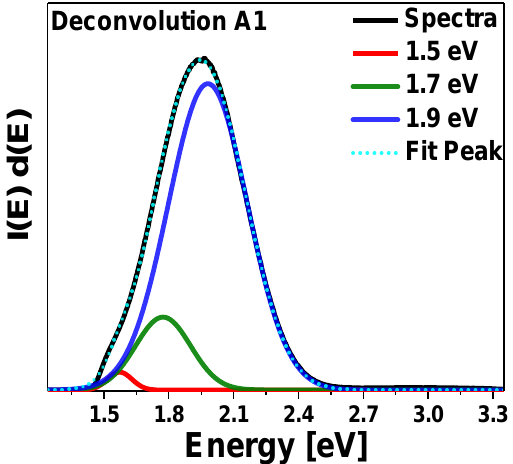
Figure 6. PL spectrum deconvolved for the A3 layer.